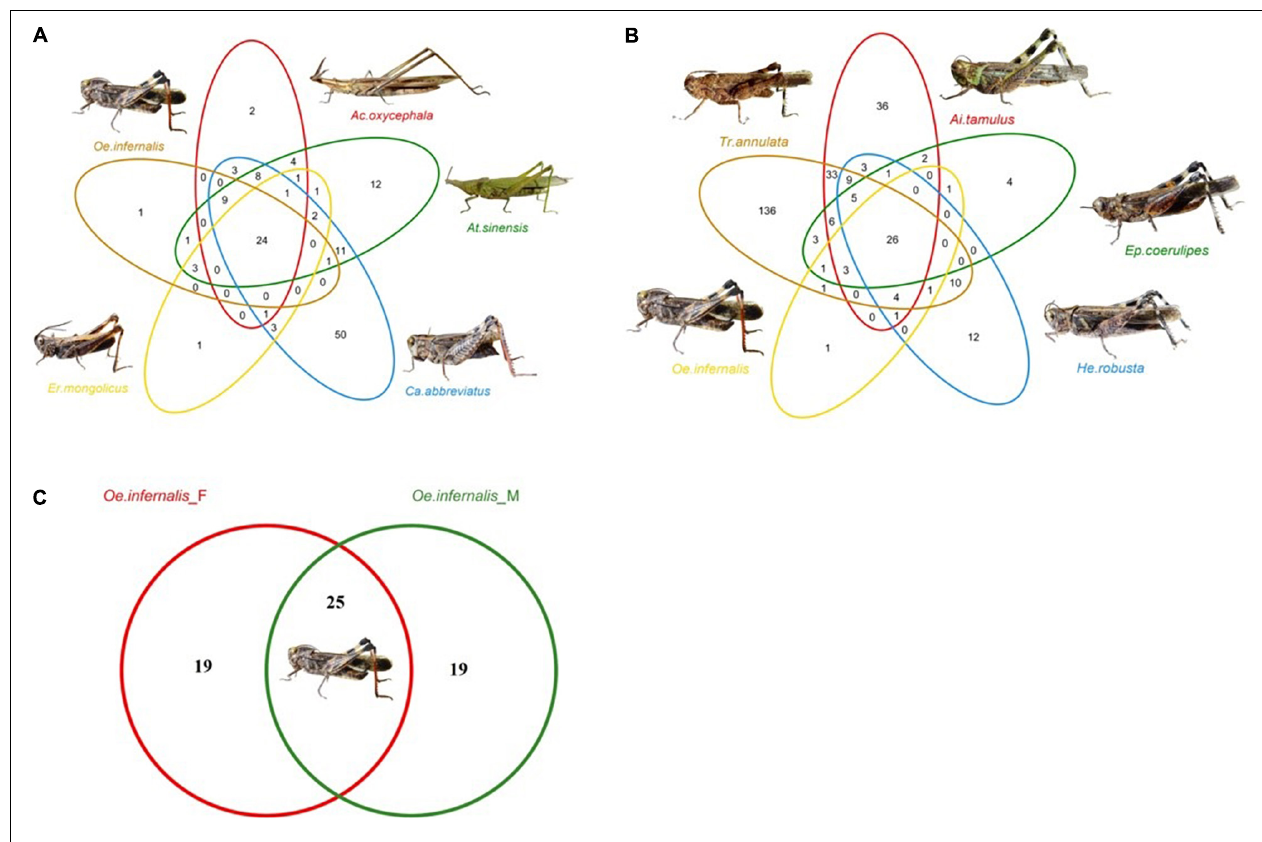
FIGURE 2 | Venn diagrams show the common and unique OTUs of three groups. (A) The gut bacteria of five families, namely At. sinensis (Pyrgomorphinae), Ca. abbreviatus (Calliptaminae), Er. mongolicus (Gomphocerinae), Ac. oxycephala (Acridinae) and Oe. infernalis (Oedipodinae). (B) The gut bacteria of Ep. coerulipes , Ai. tamulus , He. robusta , Oe. infernalis , and Tr. annulata and they belonged to Oedipodinae. (C) The gut bacteria of fore-gut and mid-gut of Oe. infernalis .